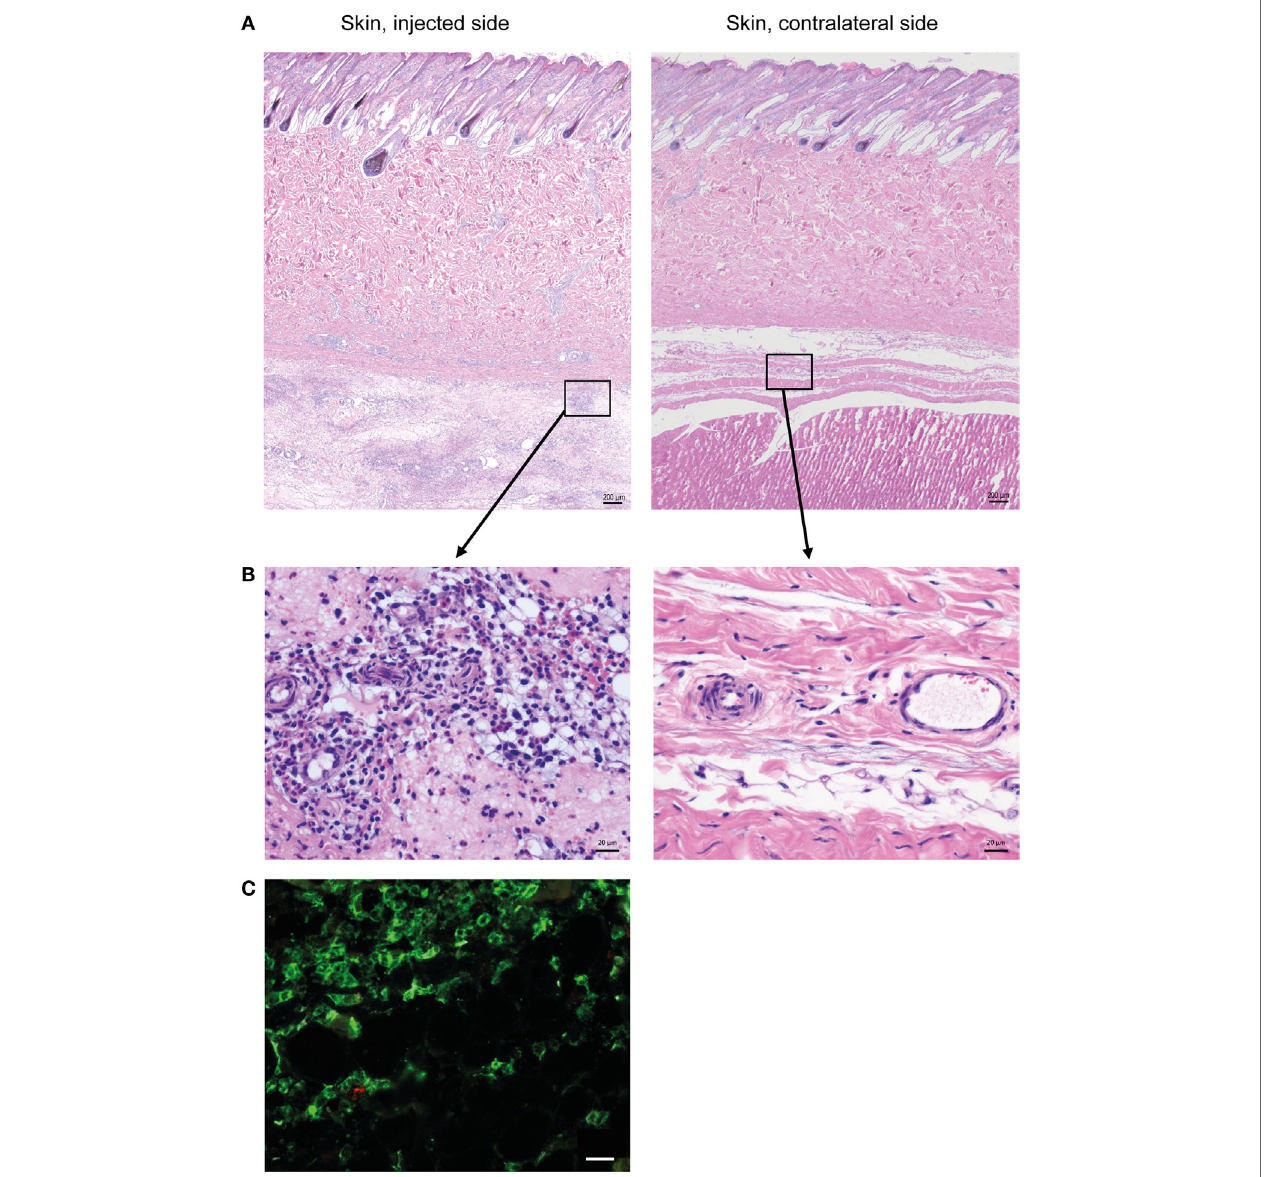
FigUre 1 | cellular recruitment to skin and subcutaneous tissues . (a) HE stained sections of skin with subcutaneous tissue from the side injected with adjuvant and the contralateral side, at 24 h post-injection. Scale bars: 200 μ m. (B) Enlargement of outlined areas in A, as indicated. Scale bars: 20 μ m. (c) Immunofluorescent labeling of subcutaneous tissue on the injected side with antibody against CD14 (green). Scale bar: 20 μ